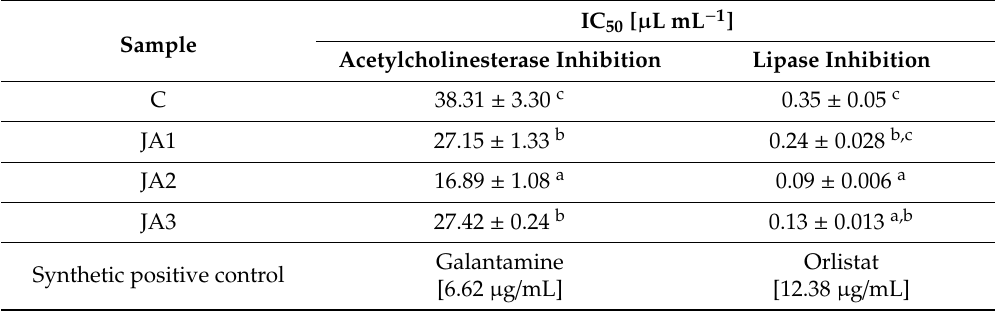
Table 1. E ff ect of jasmonic acid elicitation on acetylcholinesterase and lipase inhibitory activity of essential oil from basil.